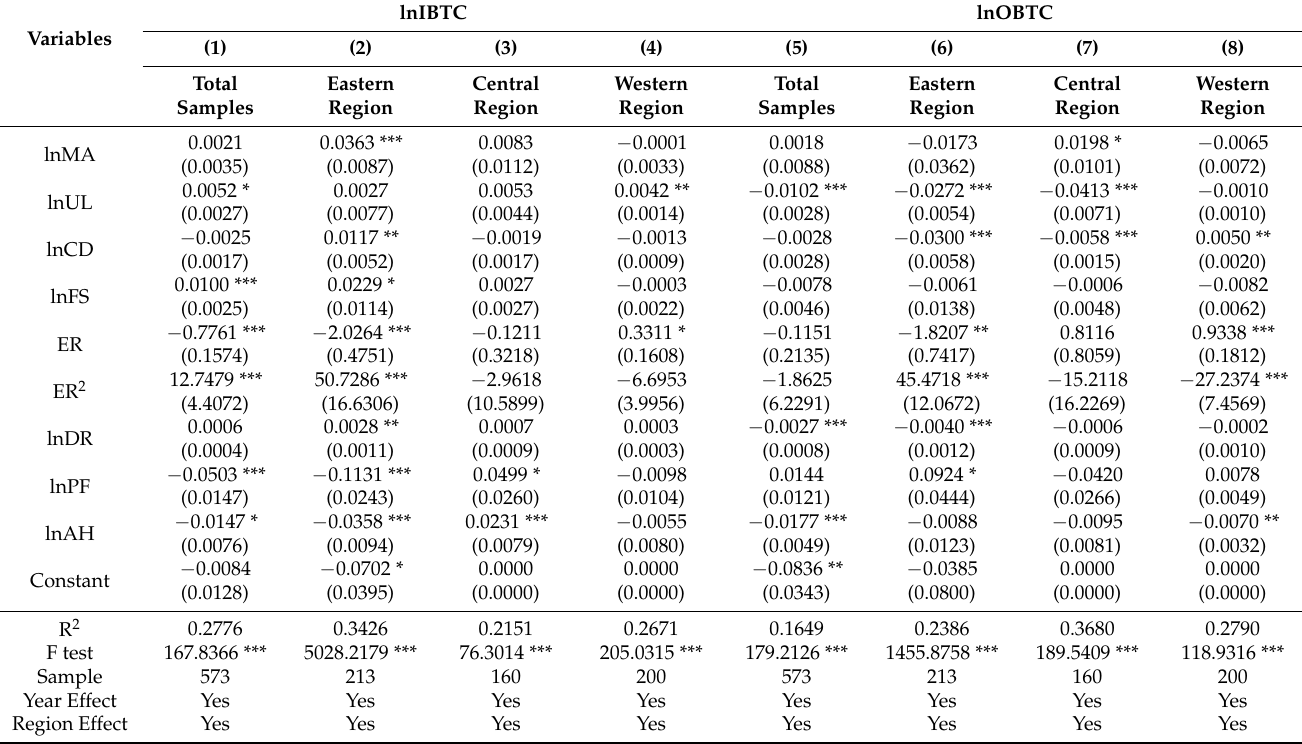
Table 11. Regression analysis results of influencing factors on green-biased technical change in Chinese